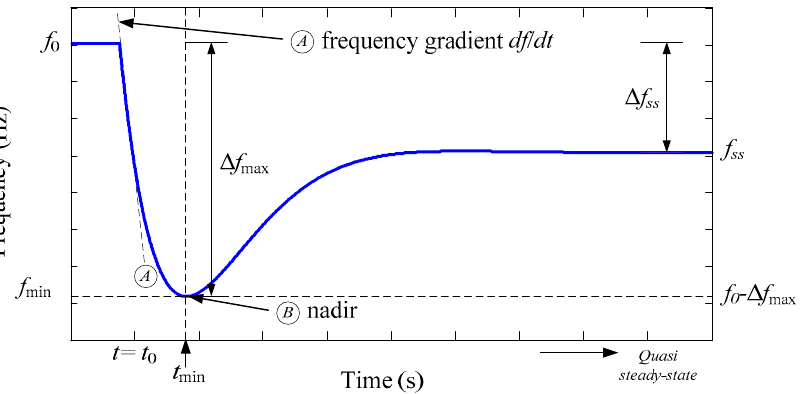
Figure 2. System frequency response (SFR) for an under-under frequency event considering primary control. The plot shows the main frequency indicators graphically as defined above. control. The plot shows the main frequency indicators graphically as defined